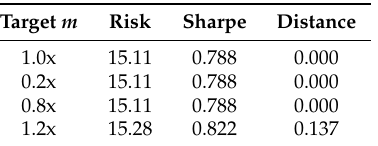
Figure 10. Distance to Risk Parity Contributions per period. Table 9. Reversion to risk parity for low target